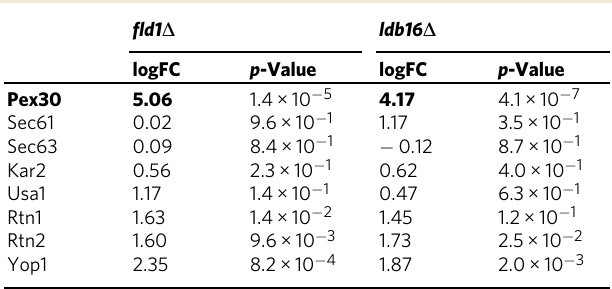
Table 1 Pex30 is enriched in LDs isolated from fl d1 Δ and ldb16 Δ